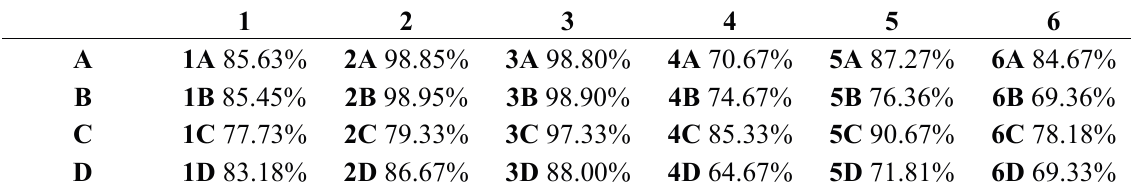
Table 3. DNA-binding effect of compounds 1 – 24 .